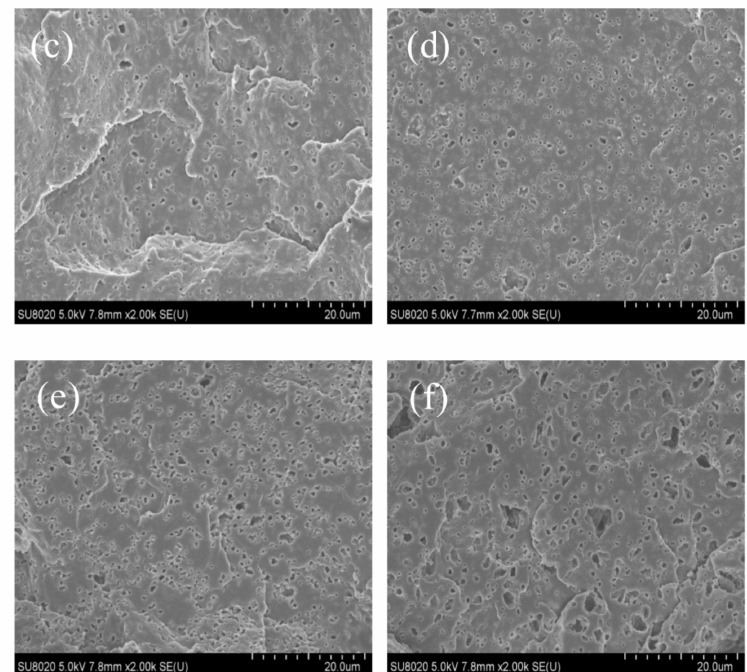
Figure 4. SEM images of Ac-SEBS/PP composites with different acetylation degrees of SEBS: ( a ): PP; ( b ): 0%; ( c ): 2%; ( d ): 4.6%; ( e ): 6%; ( f ):